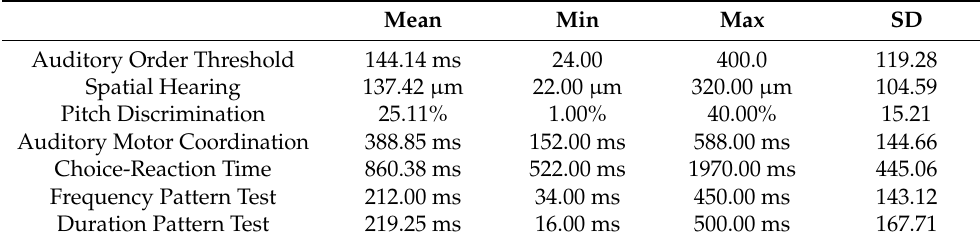
Table 3. Auditory low-level function and prosody tests.